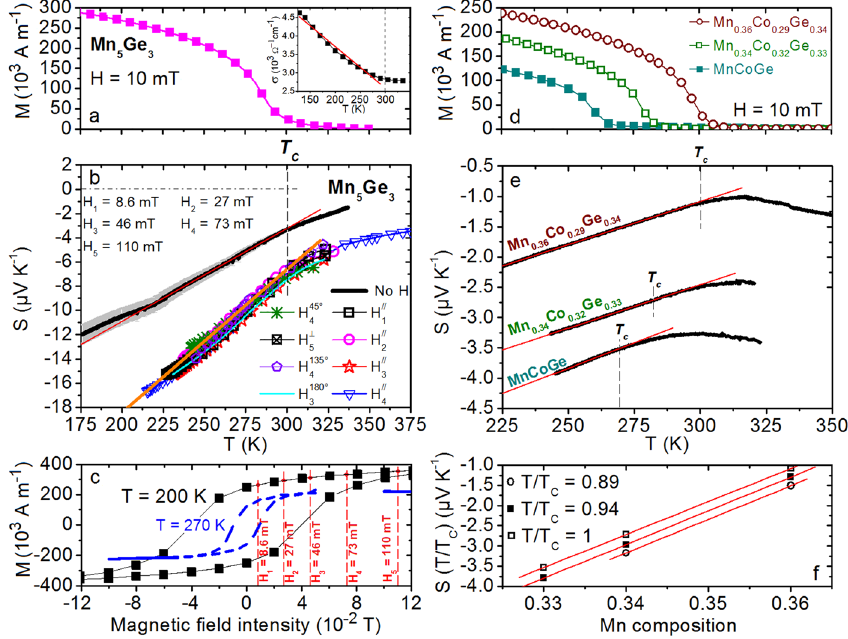
Figure 3. Magnetization ( M ) and Seebeck coefficient ( S ) measurements performed on Mn 5 Ge 3 and MnCoGe thin films. M ( a ) and S ( b ) of a 50 nm-thick Mn 5 Ge 3 film as a function of temperature. The inset in ( a ) presents the electrical conductivity of the film versus temperature. ( c ) M measured at 200 K (black solid squares) and 270 K (blue dashed line) on a same Mn 5 Ge 3 film as a function of in-plane magnetic field intensity. M ( d ) and S ( e ) of 150 nm-thick Mn x Co y Ge 1− x − y films as a function of temperature. ( f ) S ( T / T c ) of same Mn x Co y Ge 1− x − y films plotted as a function of Mn composition x .